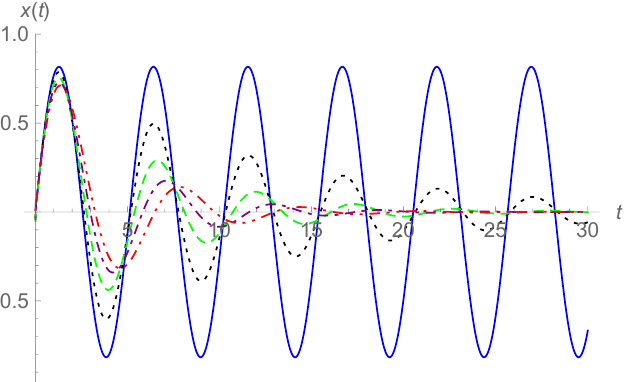
Figure 5. Curves of x ( t ) for m = k = 1, c = 0.5, and for α = 0 (solid line), 0.25 (dotted line), 0.5 (dashed line), 0.75 (dotted-dashed line), and 1 (dotted-dotted-dashed line).